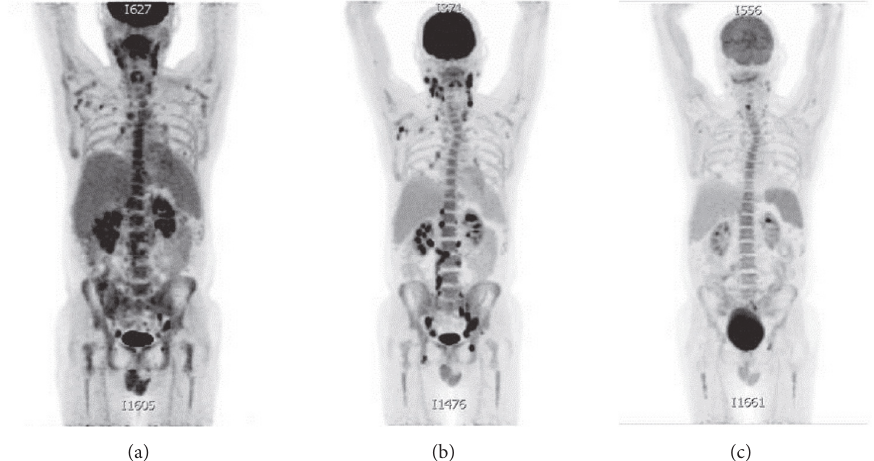
Figure 3: Staging NM-PET imaging after chemotherapy. (a) PET staging after 2 cycles of R-CHOP: partial anatomic response to therapy. Interval decrease in diffuse lymphadenopathy in comparison to initial CT. (b) Staging PET-CT after 5 cycles of R-CHOP, 1 cycle of R- DHAP, and IT methotrexate and cytarabine treatments. Widespread diffuse adenopathy with overall progression. (c) Staging after 2 cycles of brentuximab and topotecan. Significant decreases in size and metabolic activity of the diffuse adenopathy were